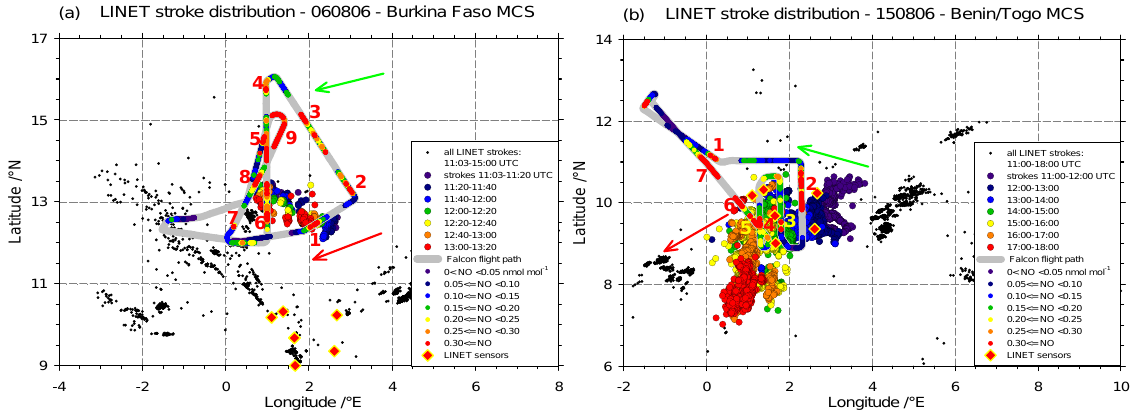
Fig. 10. Spatial and temporal LINET stroke distribution on 6 August 2006 at 11:03–15:00 UTC (a) and on 15 August 2006 at 11:00–18:00 UTC (b) (upper colour scale: only selected thunderstorm system). On 6 August, LINET data were not available before 11:03UTC. The observed NO mixing ratio along the Falcon flight path is superimposed (lower colour scale). Sequences with enhanced NO mixing ratios were observed within the MCS outflow (labelled in red). The red arrow indicates the direction of the storm motion and the green arrow the main wind direction in the anvil outflow (not scaled according to velocity). In addition, the positions of the LINET sensors are indicated (diamonds).